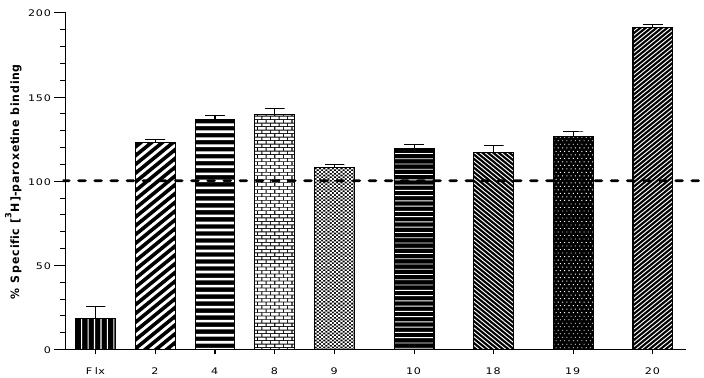
Figure 4. Graph obtained for the displacement experiments of [ 3 H]-paroxetine for the synthesized compounds [1–21] in the cellular background h-SERT induced to 2.5 × 10 − 5 M concentration. Fluoxetine (Flx) was used as a control for the compounds under study.